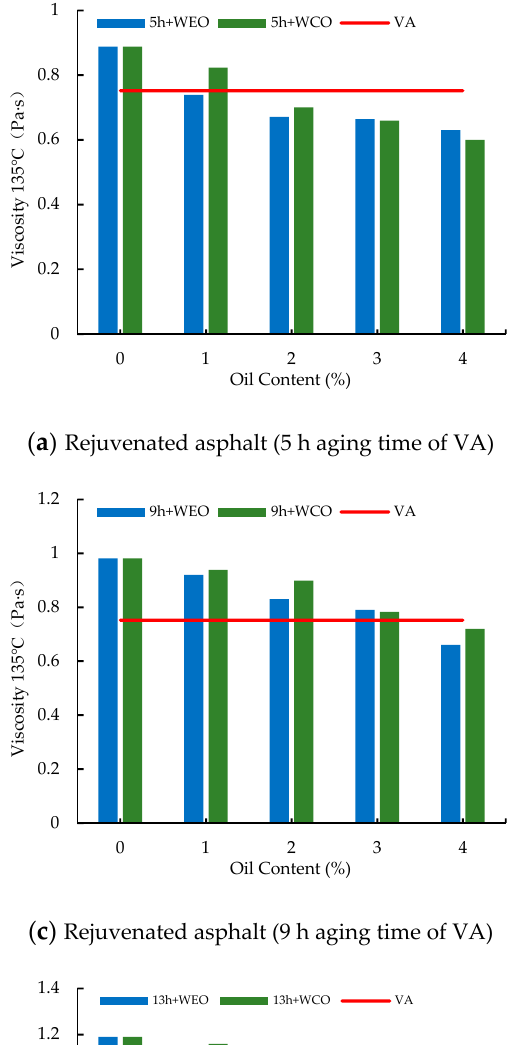
Table 3. Effect of different WEO contents on physical properties in different aged asphalts.